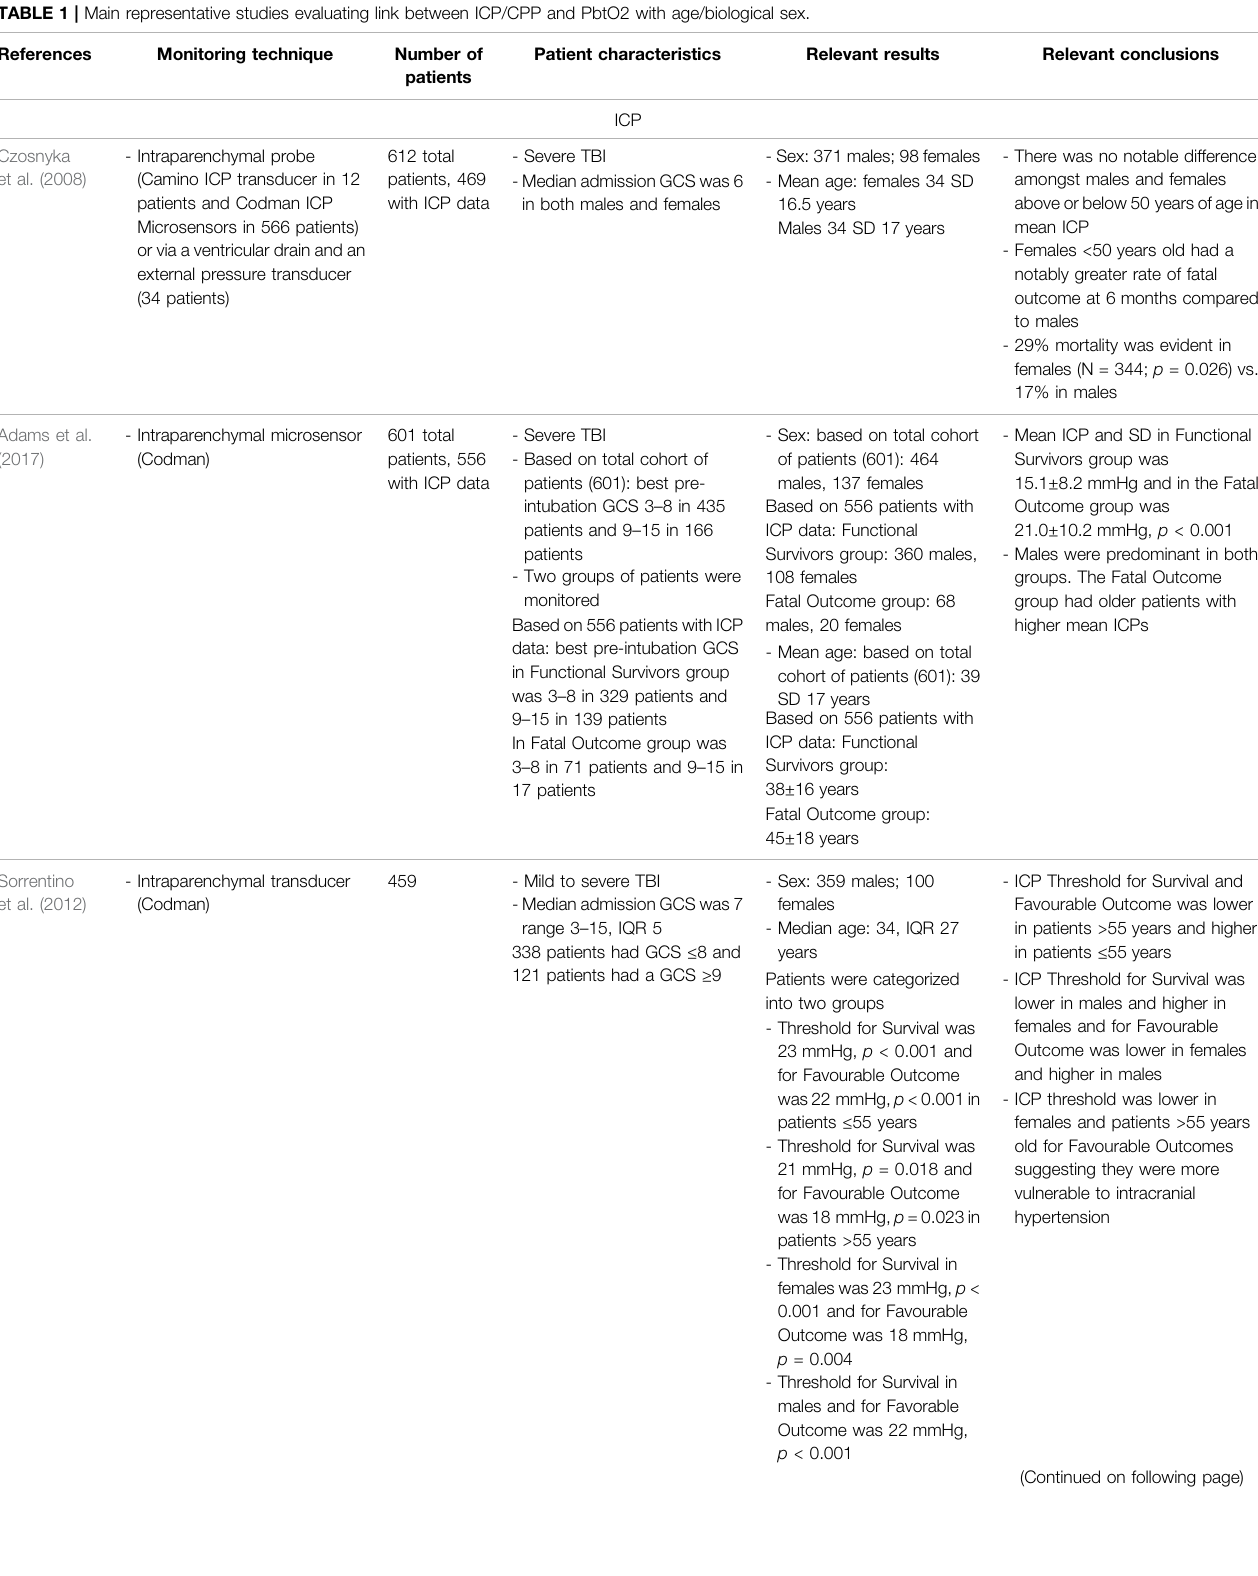
TABLE 1 | Main representative studies evaluating link between ICP/CPP and PbtO2 with age/biological